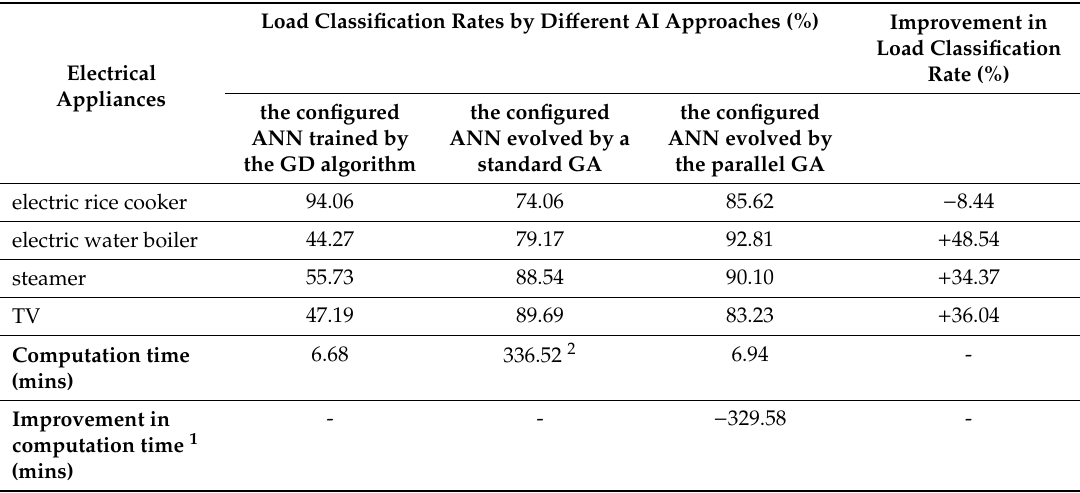
Figure 11. Evolution trajectory obtained by the parallel GA for the configured feed-forward ANN in this experiment. The algorithm determines the value of fitness as the inverse of E : the lower the error is, the higher the fitness is. Table 1. Load classification rates obtained in this